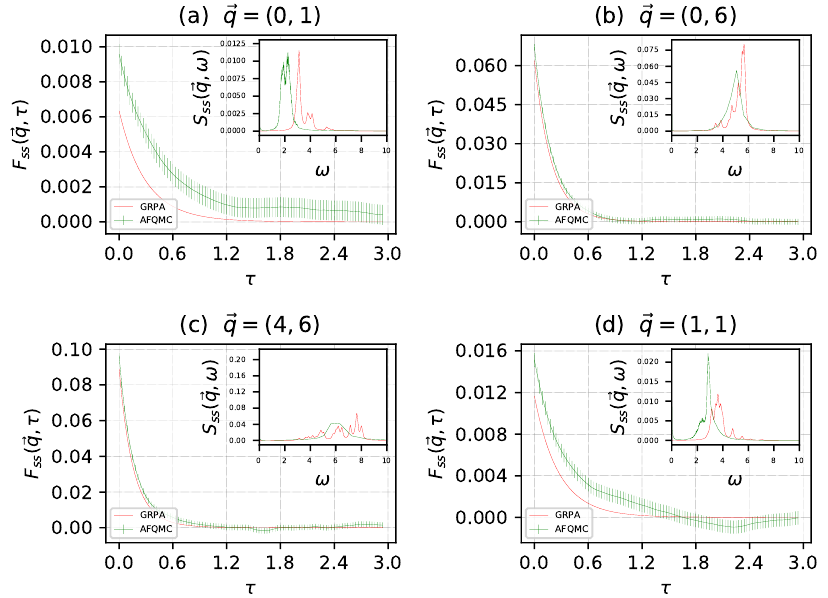
Figure 2. The spin–spin imaginary time intermediate scattering function F ss ( q , τ ) (main sub-panel), and corresponding spin–spin dynamical structure factor S ss ( q , ω ) (inset), for the momenta: q = ( 0,1 ) ( a ), q = ( 0,6 ) ( b ), q = ( 4,6 ) ( c ), q = ( 1,1 ) ( d ), in units of 2 π indicates GRPA